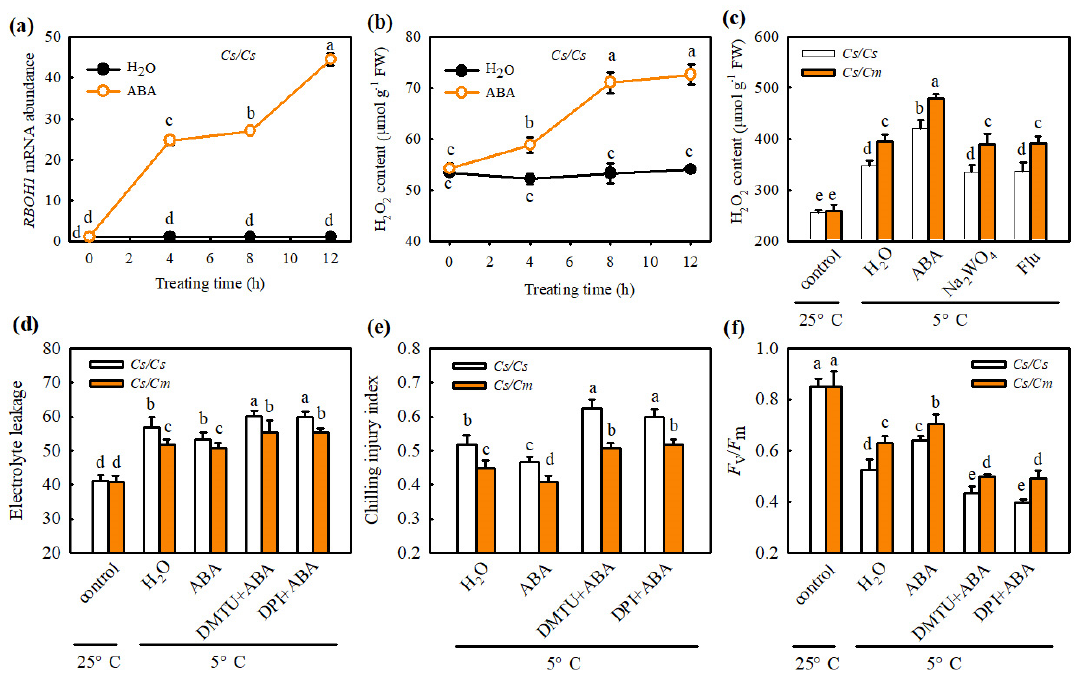
Figure 7. Effect of ABA on the H 2 O 2 biosynthesis and the role of H 2 O 2 in ABA − induced chilling tolerance in grafted cucumber. ( a , b ) RBOH1 mRNA abundance and H 2 O 2 accumulation, respectively, in Cs / Cs leaves. The Cs / Cs plants were pretreated with 50 µ M ABA or distilled water (control), and then we measured the changes of RBOH1 mRNA abundance and H 2 O 2 content within 12 h. ( c ) H 2 O 2 accumulation in Cs / Cs or Cs / Cm after chilling treatment for 0 h and 12 h. Plants were foliar sprayed with 50 µ M ABA, 3 mM Na 2 WO 4 , 50 µ M Flu, or distilled water (control) for 12 h and then exposed to chilling stress. ( d ) Electrolyte leakage of Cs / Cs or Cs / Cm plants after chilling treatment for 0 h and 48 h. ( e ) Chilling injury index of Cs / Cs or Cs / Cm plants after chilling treatment for 0 h and 72 h. ( f ) F v / F m in Cs / Cs or Cs / Cm plants after chilling treatment for 0 h and 48 h. Plants were pretreated with 50 µ M ABA, 5 mM DMTU + 50 µ M ABA, 0.1 mM DPI +50 µ M ABA, or distilled water (control) for 12 h and then exposed to chilling stress. Data are presented as the means ± SD ( n = 3). Different letters indicate a statistical significance between samples at p < 0.05.